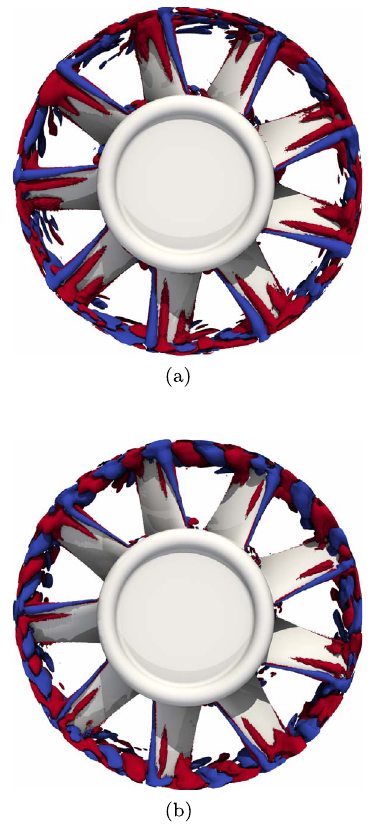
Figure 24. Constant iso-surfaces of the acoustic source term at different frequencies in the simulation. (a) Sources of PCWE at 220 Hz close to the BPF. (b) Sources of PCWE at 340 Hz at the fi rst sub-harmonic